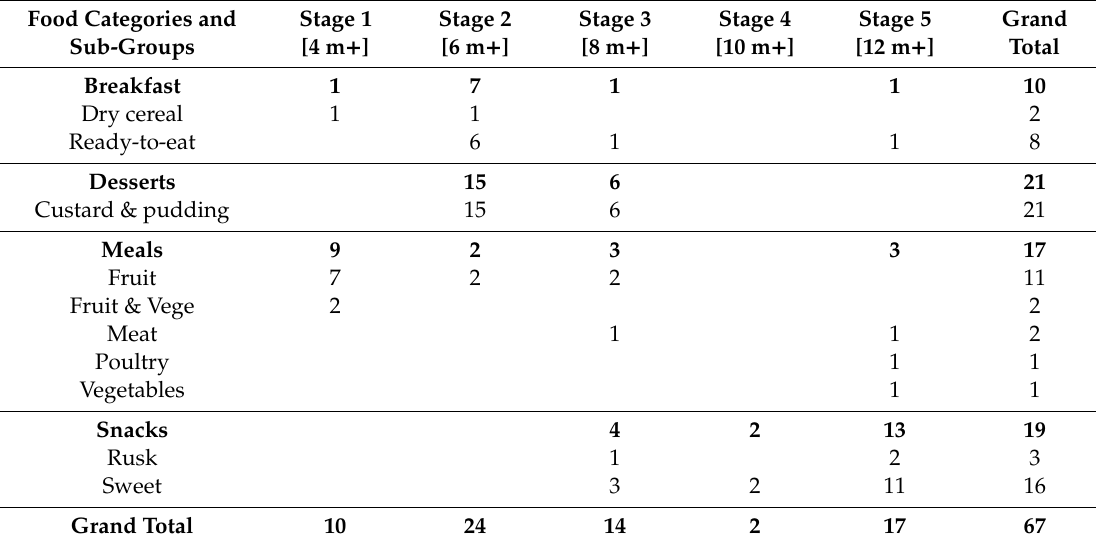
Table 3. Count of commercially available complementary foods (CACFs) in New Zealand supermarkets in 2019 that contain free sugars ( n =